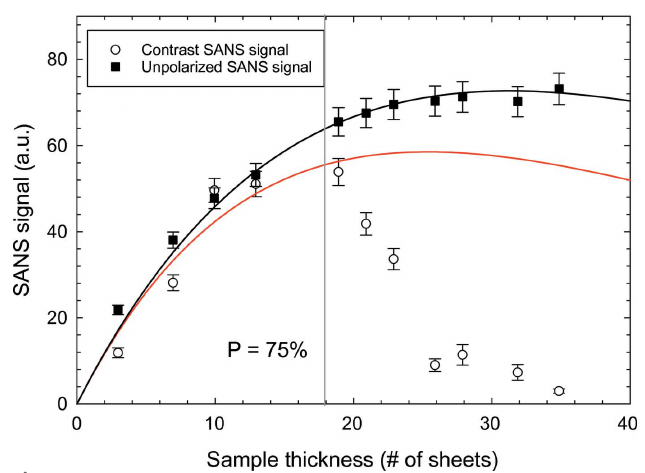
Figure 6 Normalized contrast I + (cid:3) I (cid:3) and the unpolarized I + + I (cid:3) scattering intensities as a function of the sample thickness. The unpolarized intensity I + + I (cid:3) is fitted to l exp( (cid:3) (cid:2) l ) (with fixed (cid:2) = 0.032 sheet (cid:3) 1 and only one free parameter: the scaling factor), drawn as the black solid line. The first five data points of the contrast SANS signal (the polarization for the fifth data point is calculated to be P = 74%) are fitted to equation (18) (with fixed (cid:2) = 0.032 sheet (cid:3) 1 , D = 0.016 sheet (cid:3) 1 and only one free parameter: the scaling factor), drawn as the red solid